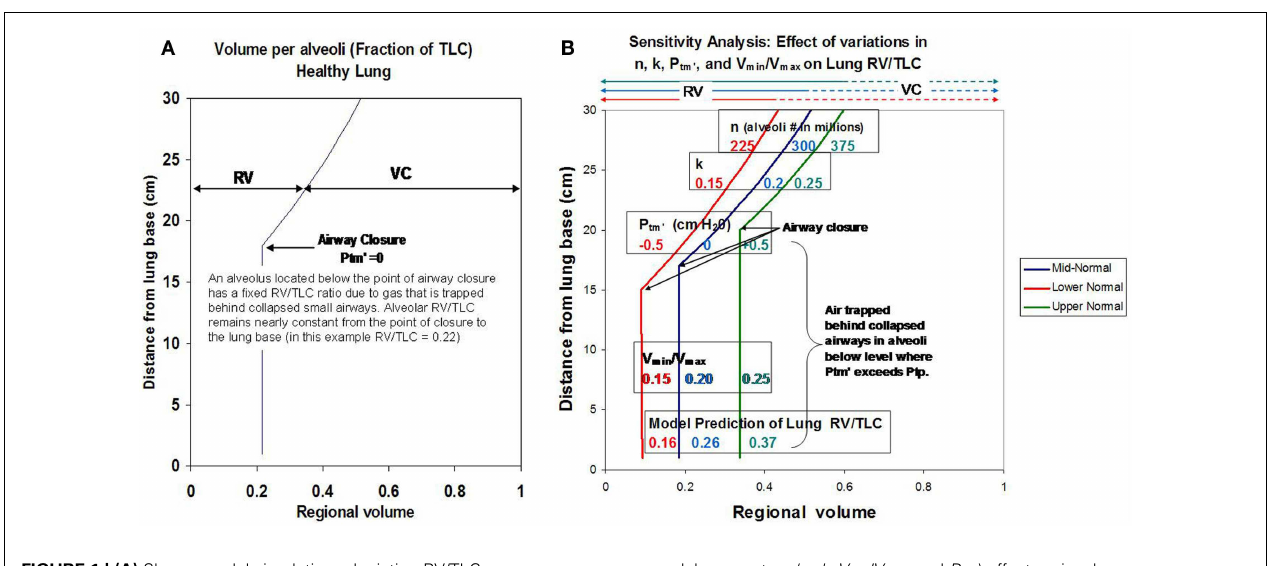
FIGURE 1 | (A) Shows model simulations depicting RV/TLC ratios for individual alveoli in the healthy lung as a function of distance from the lung base. (B) Shows how changes in key